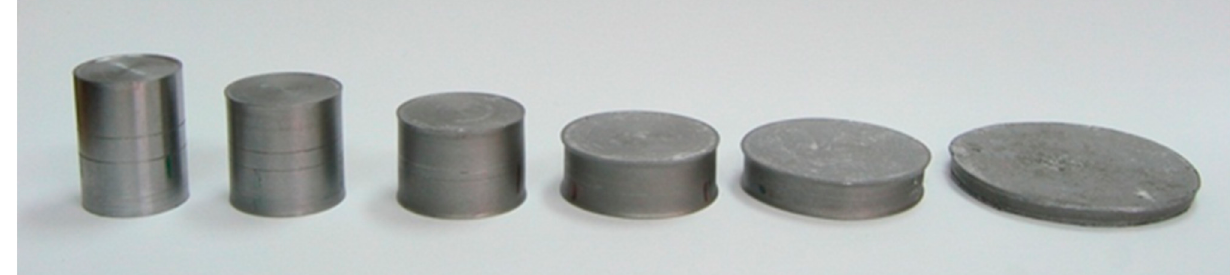
Figure 2. Shape of specimens at the instant of fracture initiation.